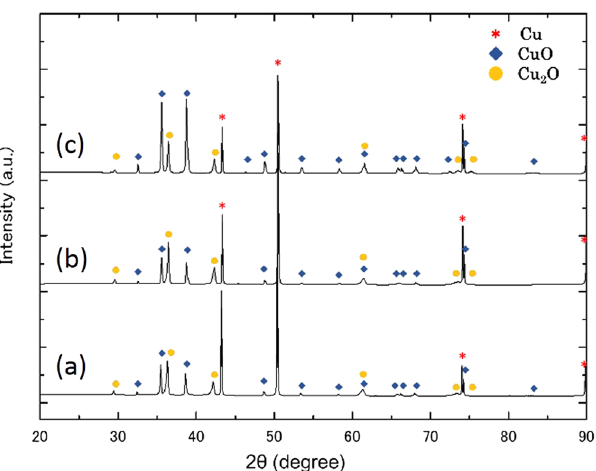
Figure 3. XRD patterns of the sample after plasma treatment and after UV irradiation. ( a ) Plasma treatment, ( b ) UV 5 hours, and ( c ) UV 24